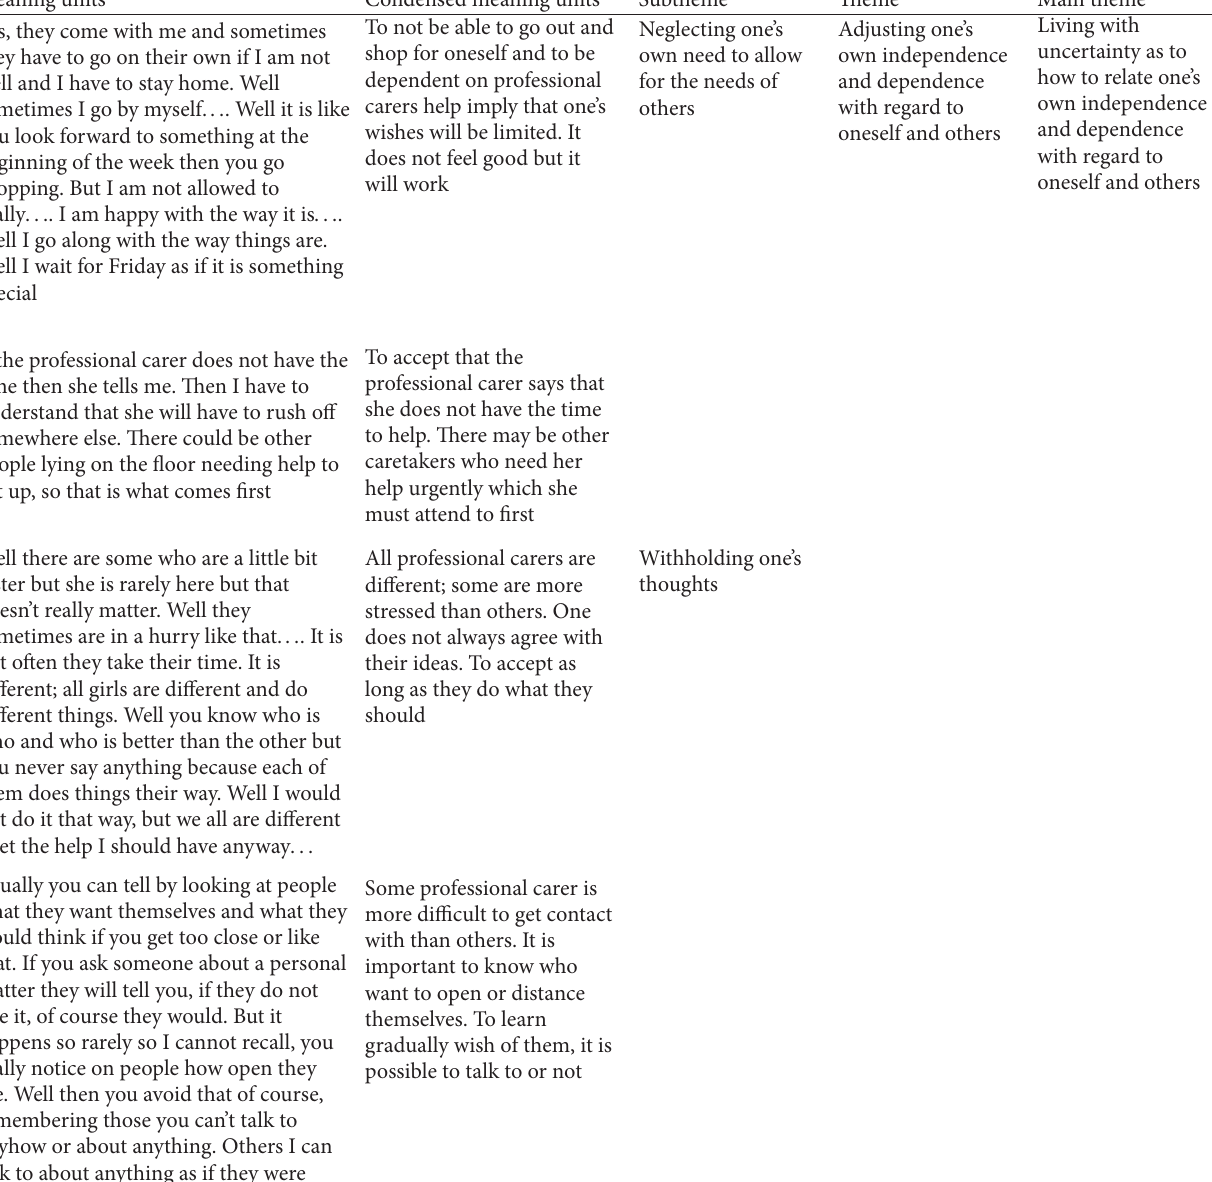
Table 1: Examples of the structural